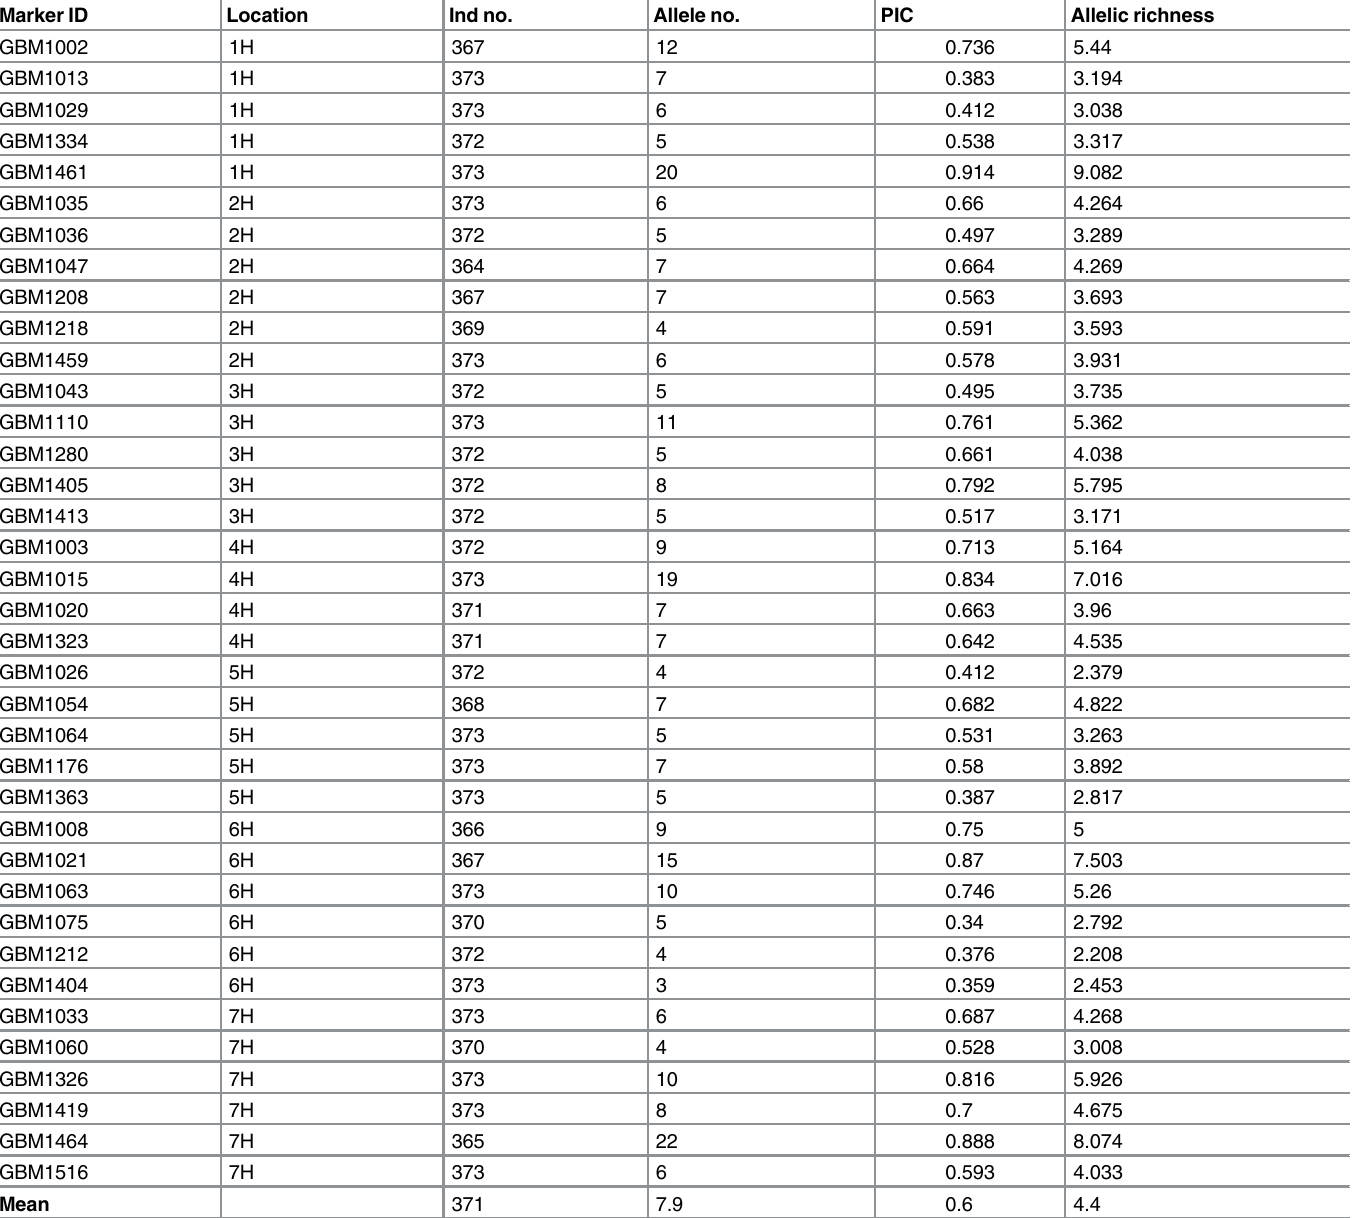
Table 3. Characteristics of SSR